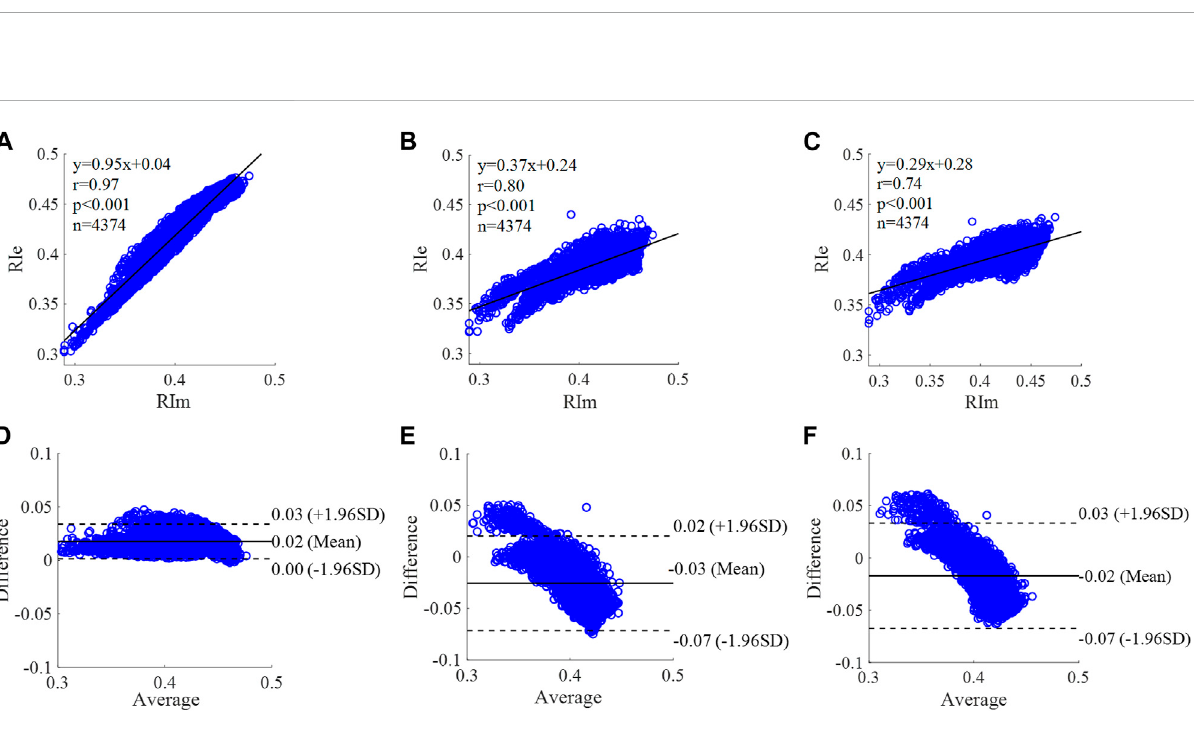
FIGURE 12 Correlation graphs and Bland-Altman plots of RI calculated by three fl ow waveforms. (A) and (D) Results of the personalized fl ow wave (Nektar1D PWDB, 4,374 subjects); (B) and (E) Results of the triangular fl ow wave (Nektar1D PWDB, 4,374 subjects); (C) and (F) Results of the lognormal fl ow wave (Nektar1D PWDB, 4,374 subjects). RIm and RIe are measured and estimated RI, respectively. Difference: RIe - RIm; Average: (RIe +